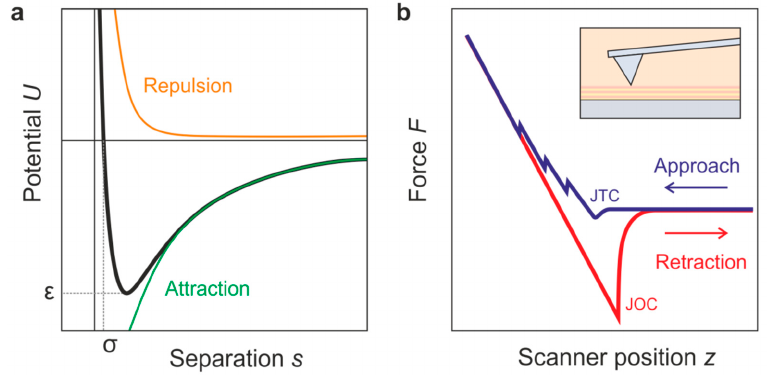
Figure 7. ( a ) Lennard–Jones potential describing the force between the tip and a solid surface related to attractive and repulsive interaction; ( b ) schematic illustration of a typical static-mode force curve obtained during approach and retraction of a solid surface in an ionic